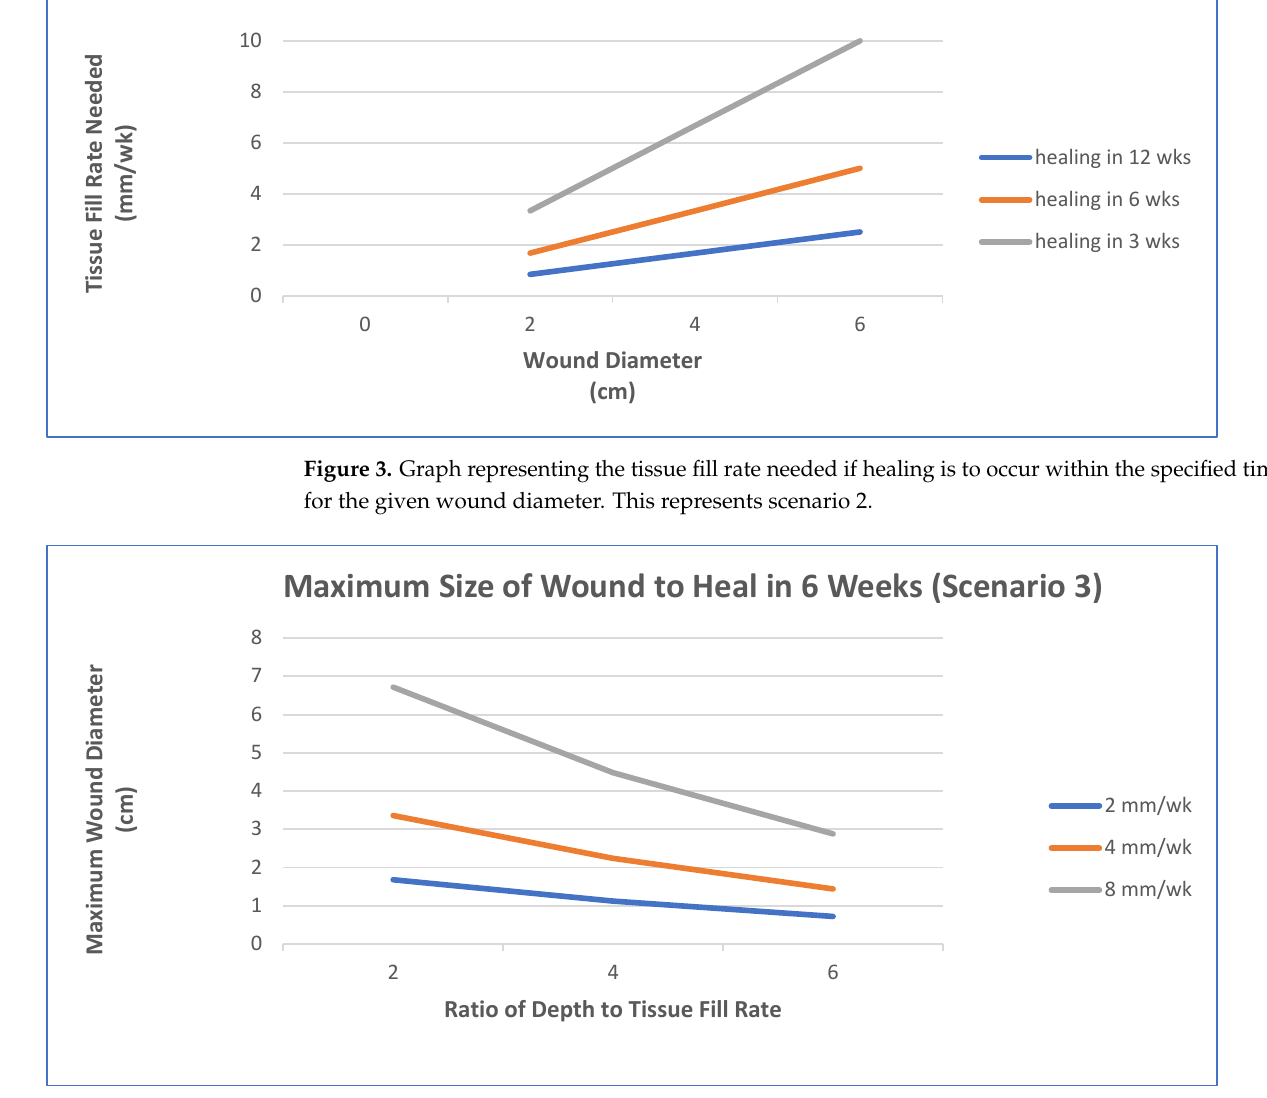
Figure 4. Graph illustrating the maximum size of wound that could heal in 6 weeks with 3 healing rates for a given depth to tissue fill rate (assuming healing does not start until 80% of the tissue fill is complete) (Scenario 3).